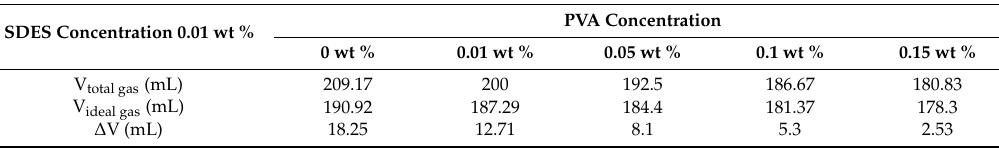
Table 1. The values of the volume of gas ( ∆ V), total gas volume (V total gas ) and ideal gas supply volume (V ideal gas ) at an SDES concentration of 0.01 wt